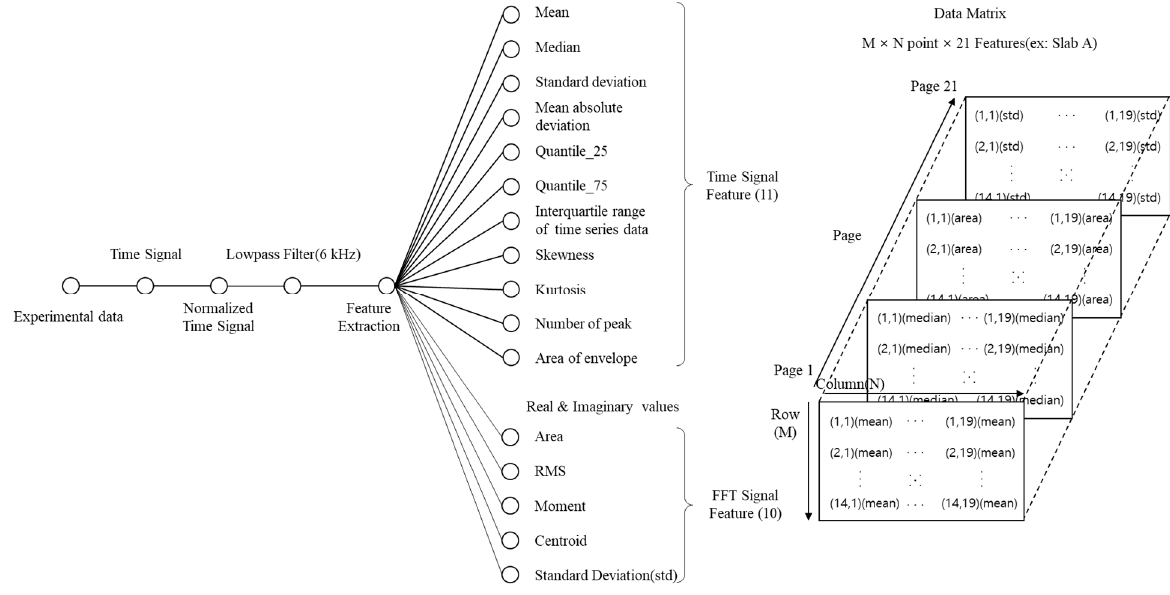
Figure 8. Signal processing and feature extraction procedure for PCA.